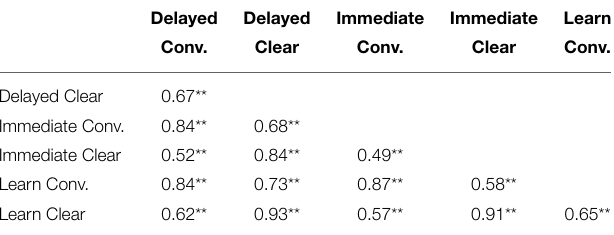
TABLE 7 | Correlations between dependent variables for conversational (conv.) and clear